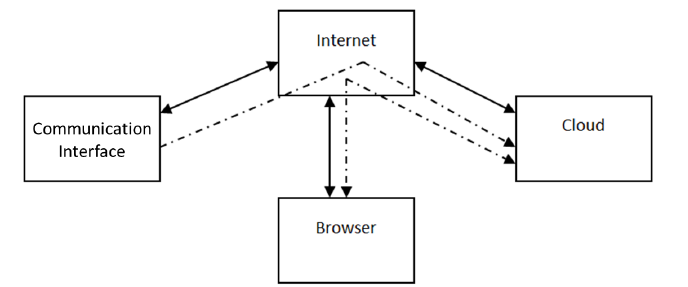
Figure 6. Block diagram of the communication scheme between data derived from SO and the external